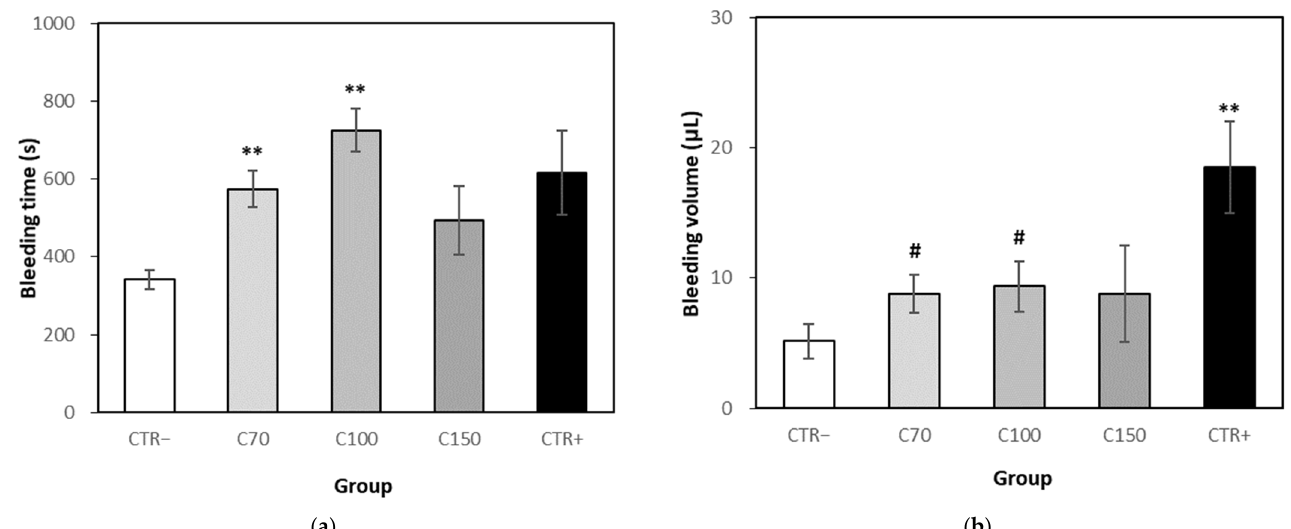
Figure 5. Effect of CKE on tail bleeding time and volume. The test samples were administered orally once a day for 7 days. Result expressed as a mean ± SEM. ( a ) Effect on the bleeding time, ( b ) Effect on the bleeding volume). ** represents p < 0.01 compared to CTR- group; # represents p < 0.05 compared to CTR+ group. Abbreviation: CTR − , Vehicle control (distilled water), n = 6; C70, CKE 70 mg/kg/day, n = 6; C100, CKE 100 mg/kg/day, n = 6; C150. CKE 150 mg/kg/day, n = 6; CTR+, Positive control (aspirin 100 mg/kg/ day), n = 6.